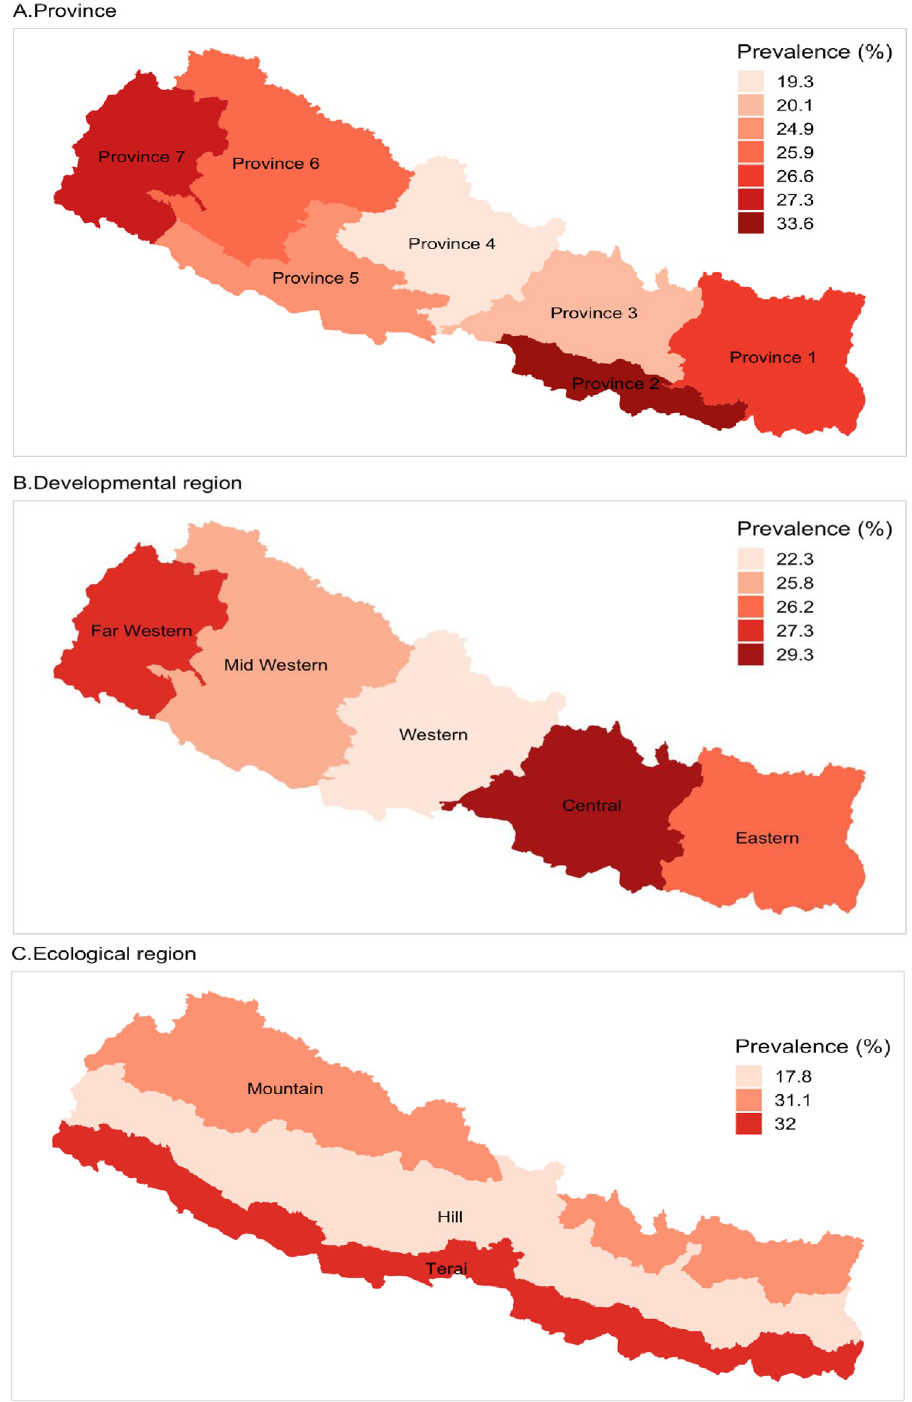
Fig 5. Regional variations in prevalence of moderate to severe anemia among Nepalese children.